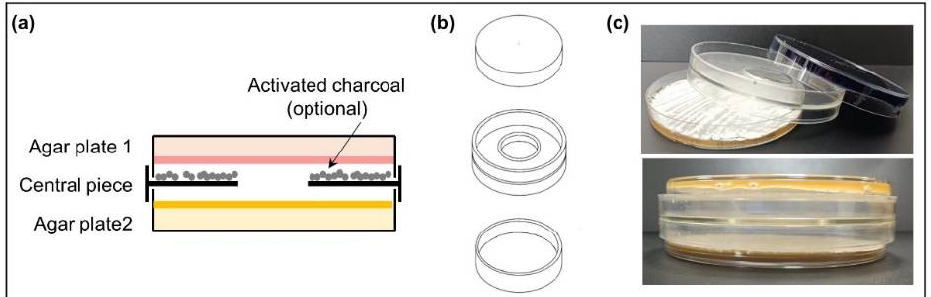
Figure 1. Volatile compound ( VOC) chamber. ( a ) Schematic side-view of a VOC chamber; ( b ) representation of each part of the VOC chamber device. The hole in the middle allows the exchange of VOCs between cultures (modified from [25]); ( c ) photographs of an assembled VOC chamber (without charcoal).